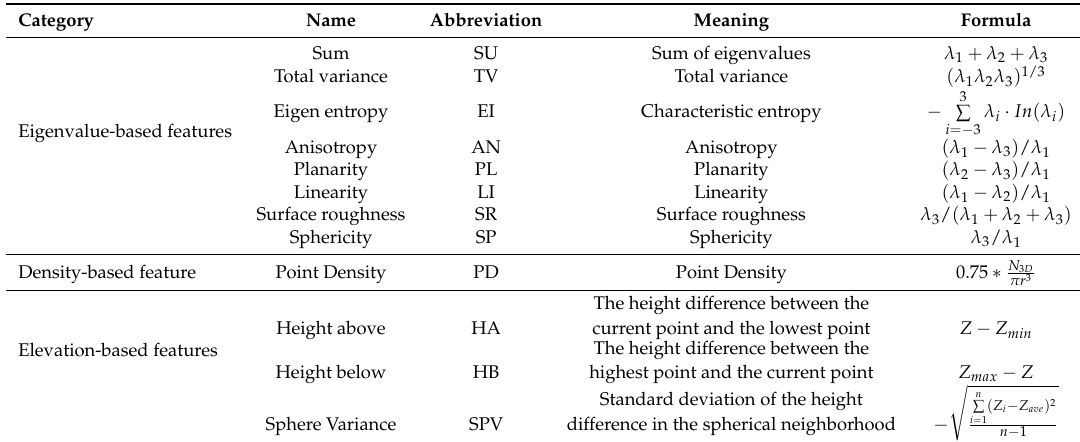
Table 1. Point cloud